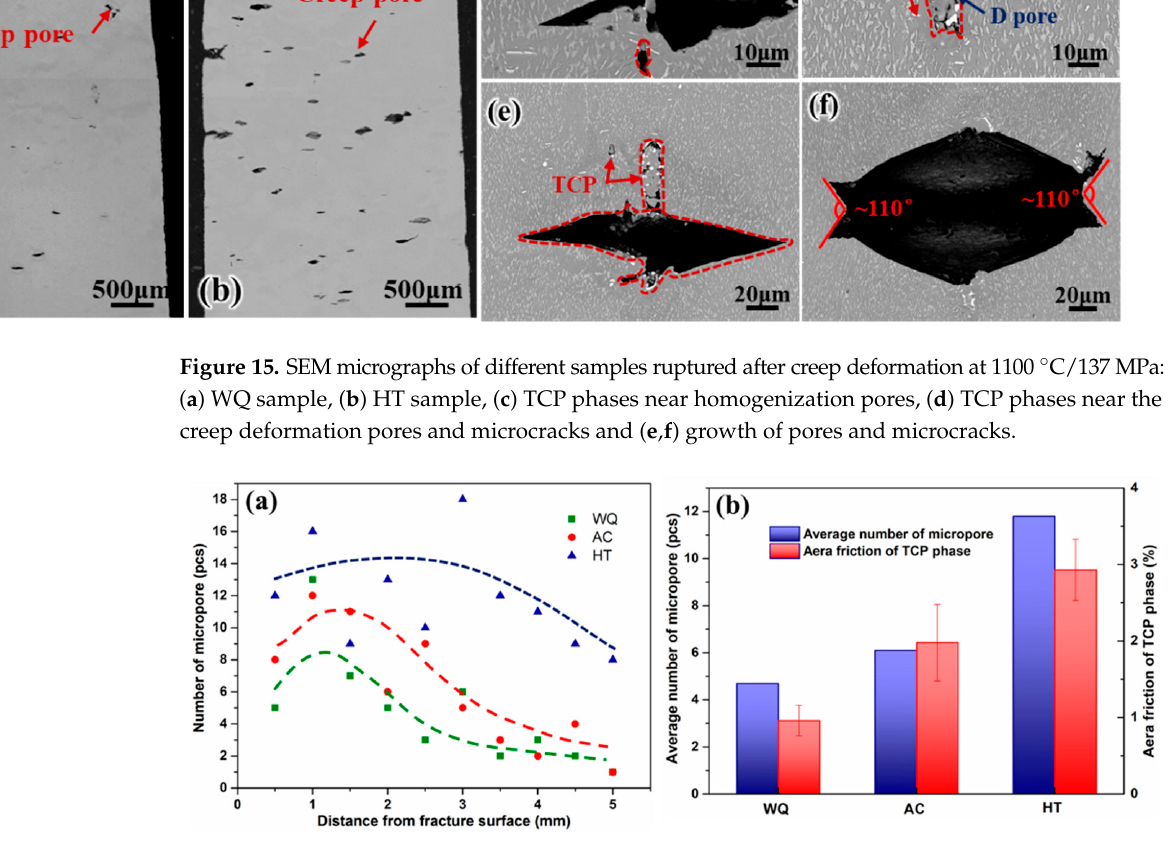
Figure 16. ( a ) number of micropores varies with the distance from the fracture surface and ( b ) histogram of average number of micropores and TCP phase area fraction. Compared with HT samples, the number of micropores in WQ samples was signifi- cantly less, as shown in Figure 16a. Further observation of the microstructure around the micropores and microcracks revealed that a large number of TCP phases are